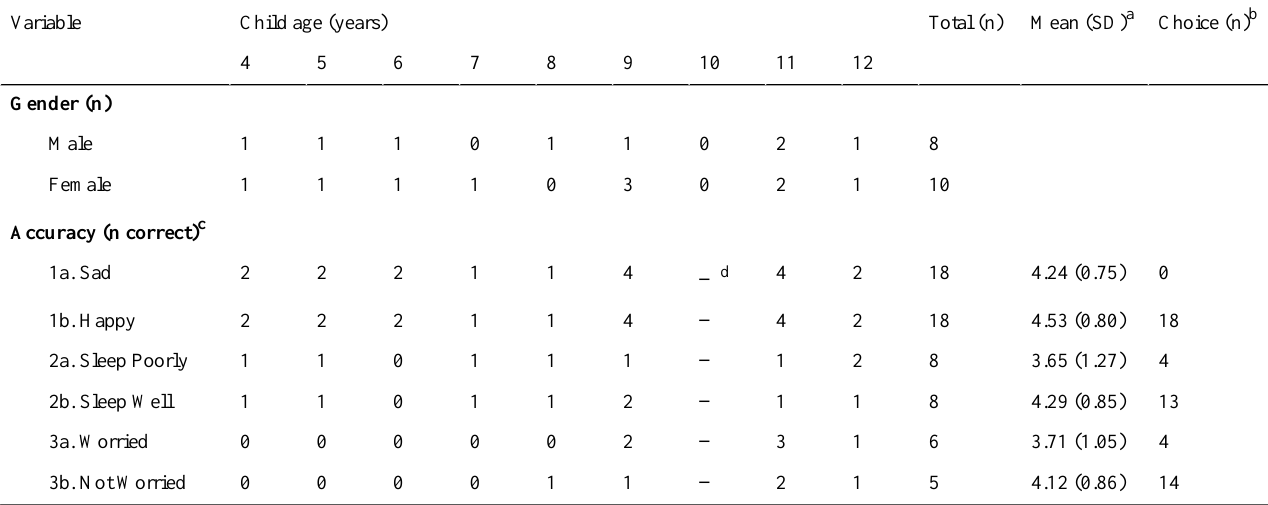
Table 2. Descriptive statistics from child interviews showing age, gender, and response characteristics for participating